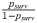
SHAP feature importance metrics for 4 patients that were incorrectly predicted as deceased.Output values (bold), expressed as log odds ratio of probability of survival to probability of deceased (i.e. log(psurv1−psurv)), that are < 0 represent deceased patients. Blue bars indicate that the feature value is increasing the probability of survival while red bars indicate that the feature is decreasing it. In all 4 cases, there was one feature that dominated the model prediction.